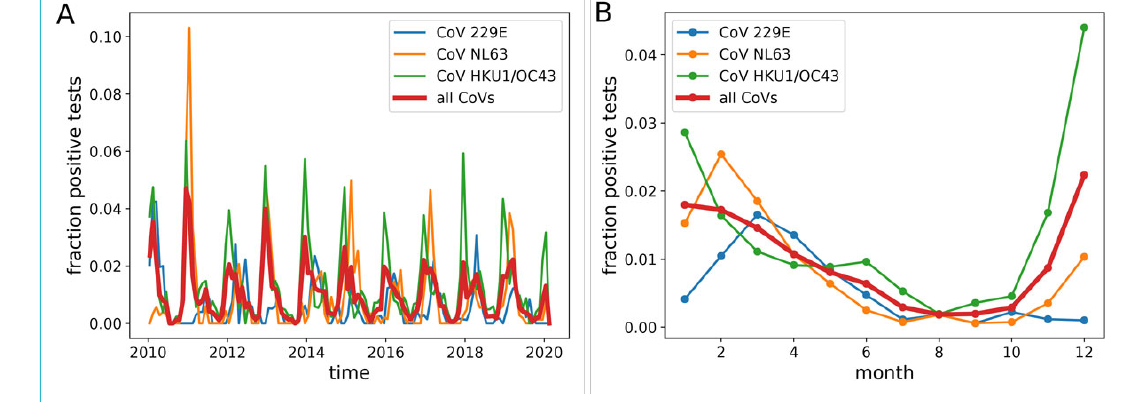
Figure 1: Seasonal variation in the fraction of positive CoV tests in Stockholm, Sweden. Panel A shows test results between 2010 and 2019. Panel B shows aggregated data for all years. All CoVs show a marked decline in summer and autumn, with HKU1/OC43 peaking January–De- cember, and NL63 and 229E peaking in